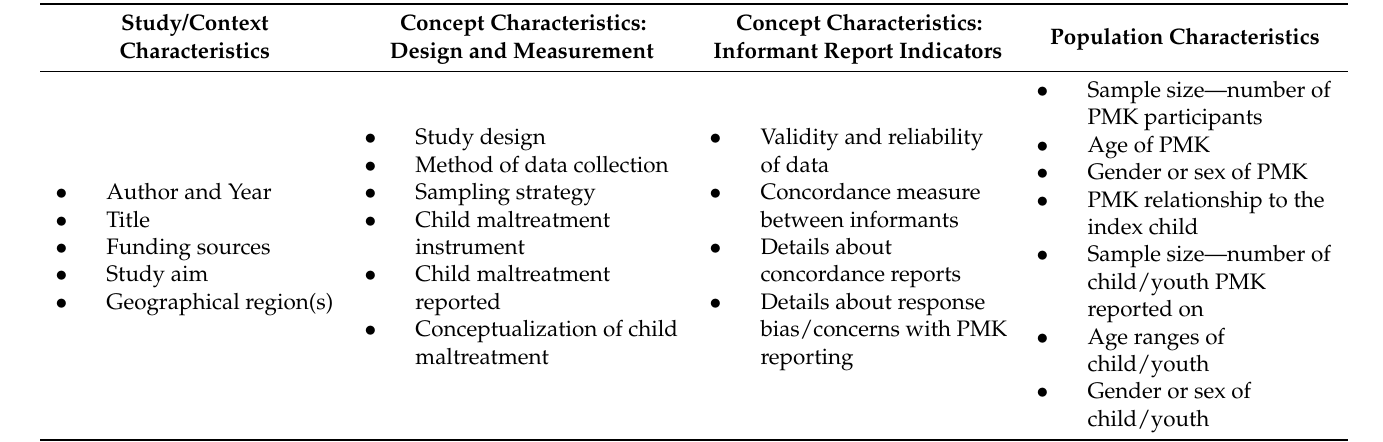
Table 1. Data extraction